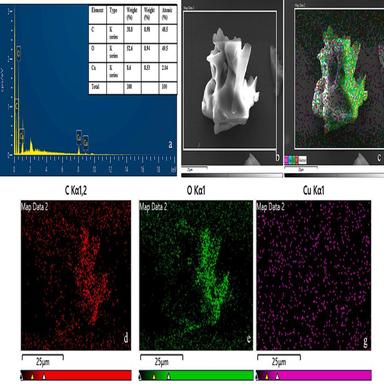
EDX-SEM analysis of HPMC / copper nanobiocomposites. Elemental analysis of HPMC / copper nanobiocomposites.